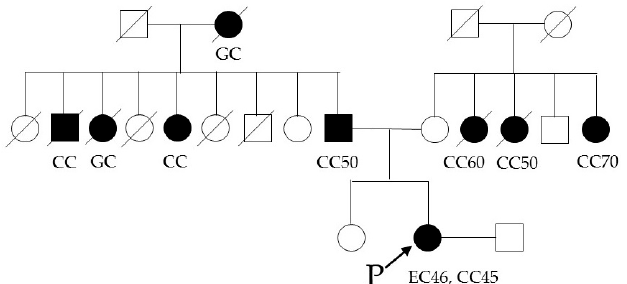
Figure 3. Family tree of the patient with MLH1 epimutation. The patient had familial accumulation of Lynch-associated cancers, met the revised Bethesda guidelines, and met the Amsterdam II criteria. Numbers written in the figure are age at onset when known. CC: colorectal cancer, EC: endometrial cancer, GC: gastric